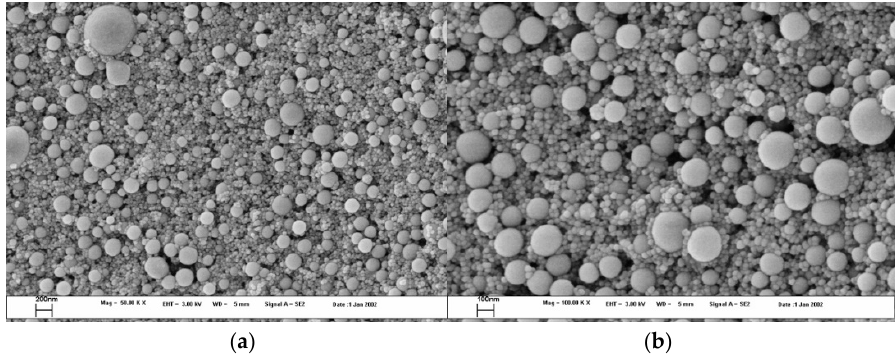
Figure 12. SEM micrographs of SMCs with DCOIT.